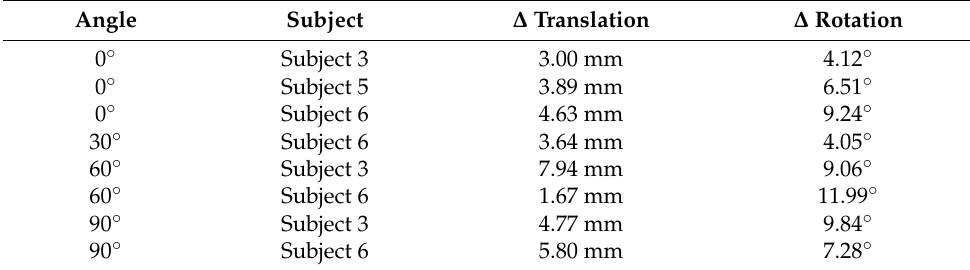
Table 3. Inter-operator variability